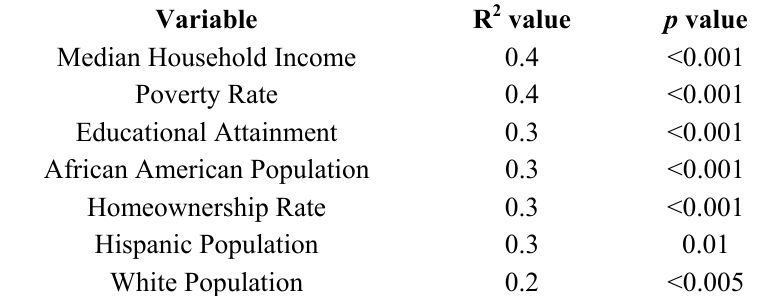
Table 2. Demographic variables and BLL correlation measures for correlation of BLLs ≥ 5 µg/dL with demographic variables for all MA